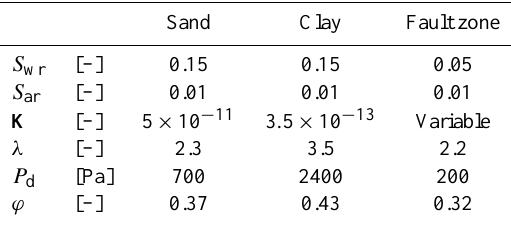
Table 2. Soil parameters for two-phase flow